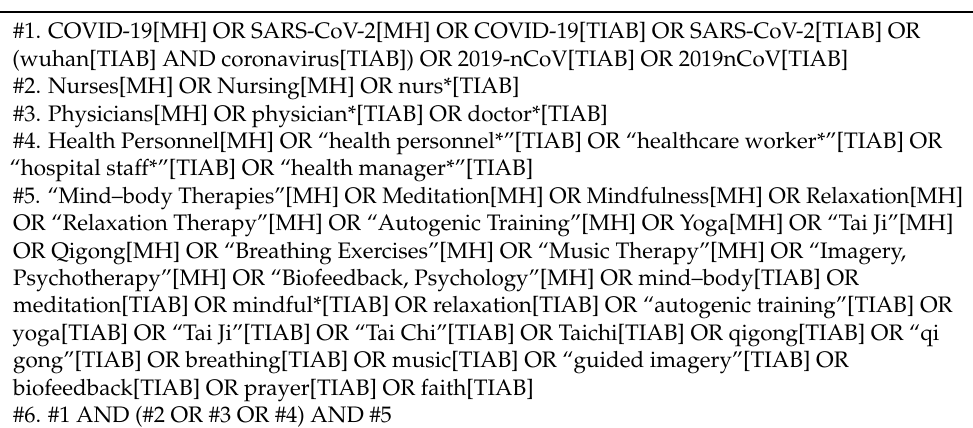
Table 1. Search strategies for the Medline via